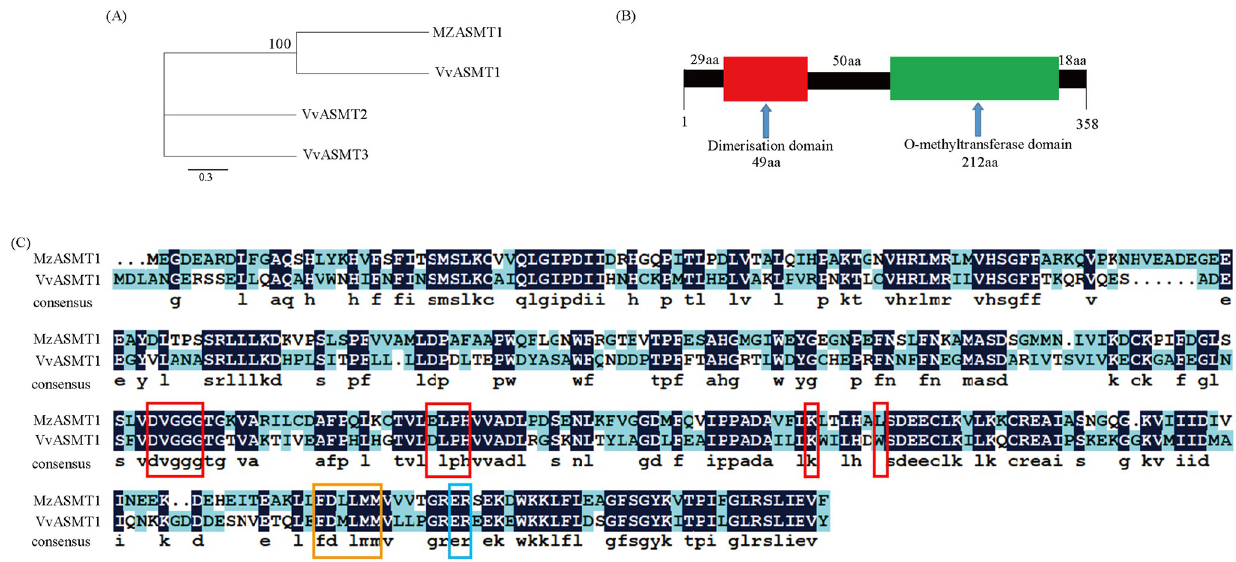
Fig 1. Bioinformatic analysis of the VvASMT1 protein. (A) Phylogenetic tree was constructed using the protein sequences of three grape ASMTs and apple ASMT1. (B) Schematic diagram of the domain organization of the VvASMT1. (C) Multiple sequence alignment of predicted VvASMT1 protein sequence with MzASMT1. The binding region of adenosine-L-methionine is marked by red frame, the binding region of substrate is marked by blue frame, and the catalytic region is marked by orange frame. VvASMT1 (GSVIVT01020642001), MzASMT1 (KJ123721). Vv, Vitis vinifera ; Mz, Malus zumi .